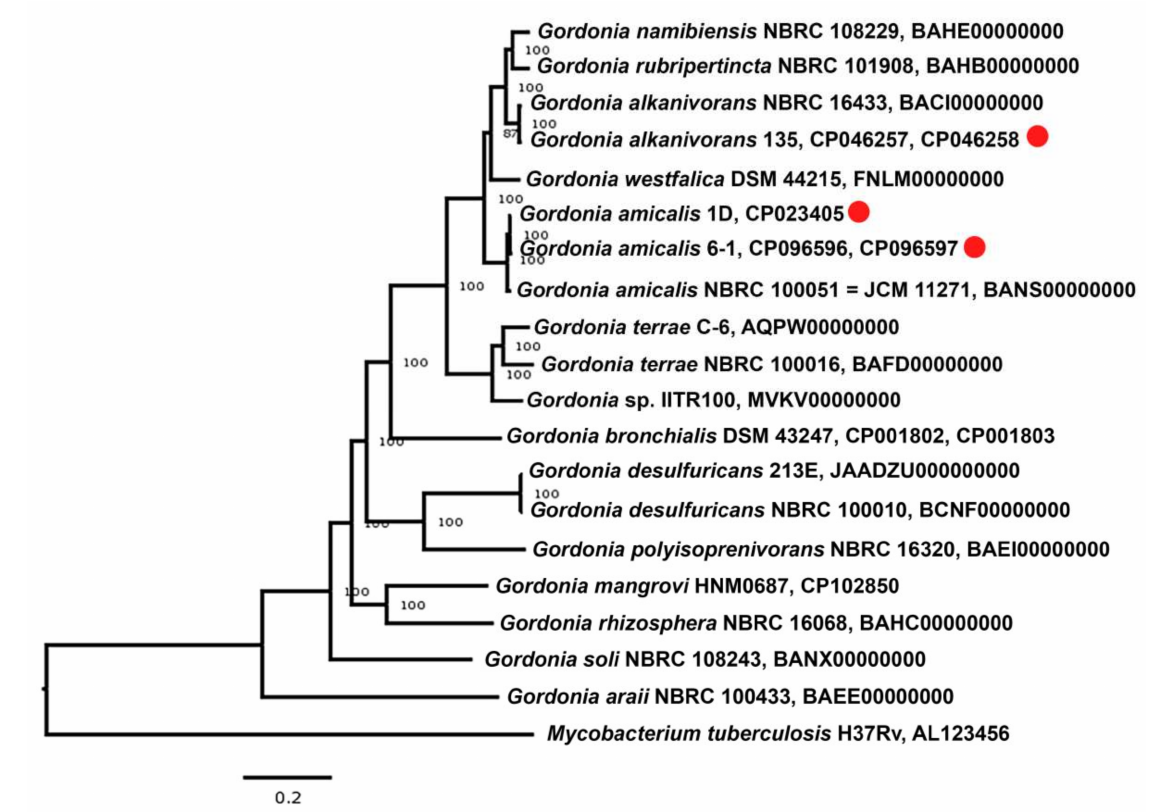
Figure 2. Whole-genome tree of the studied Gordonia strains (red markers) and other members of the genus Gordonia carried out using the PATRIC [https://www.bv-brc.org/, accessed on 14 September 2022] and iTOL [https://itol.embl.de/, accessed on 22 September 2022] services with default